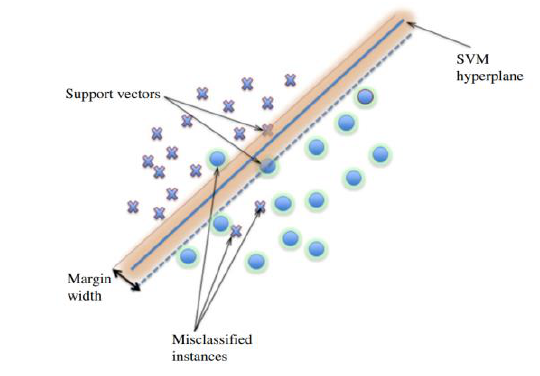
Figure 4. The specification of hyperplane and support vectors to separate data (Mountrakis, Im, and Ogole 2011).